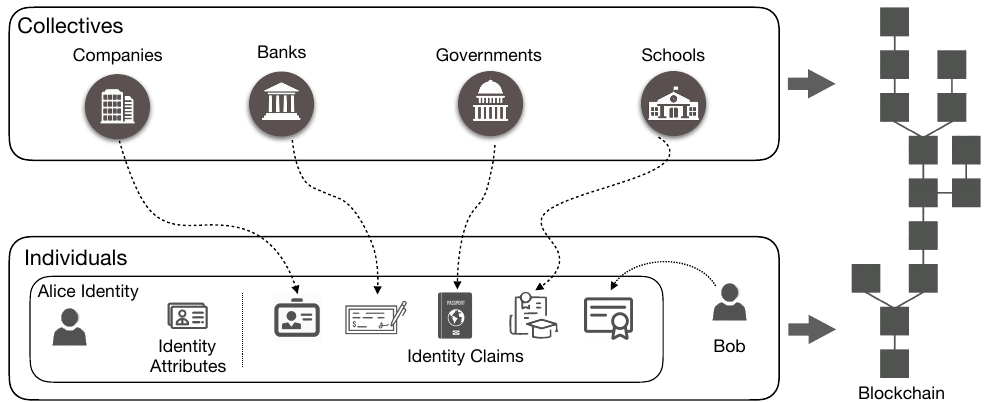
Figure 2. Overview of blockchain based identity management